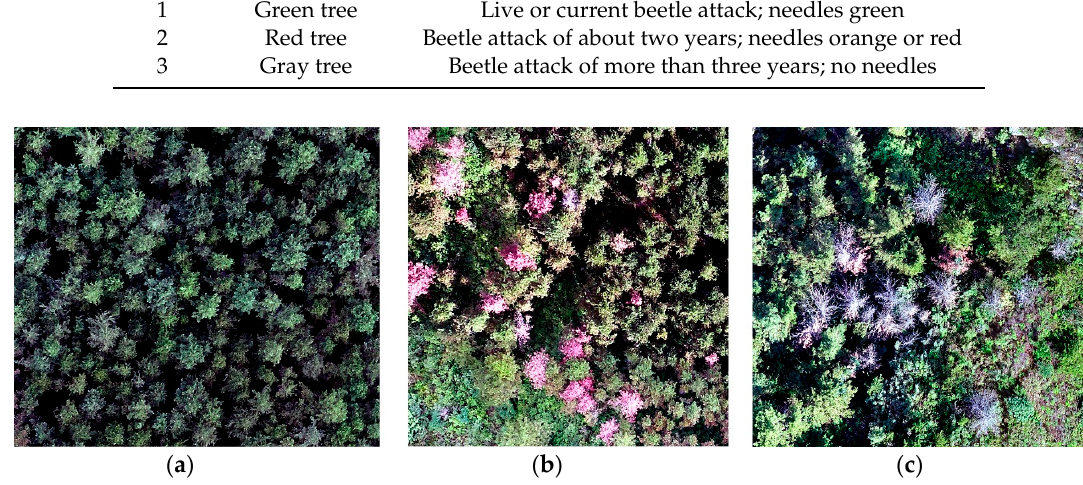
Figure 2. Examples of green trees ( a ), red trees ( b ), and gray trees ( c ) in UAV